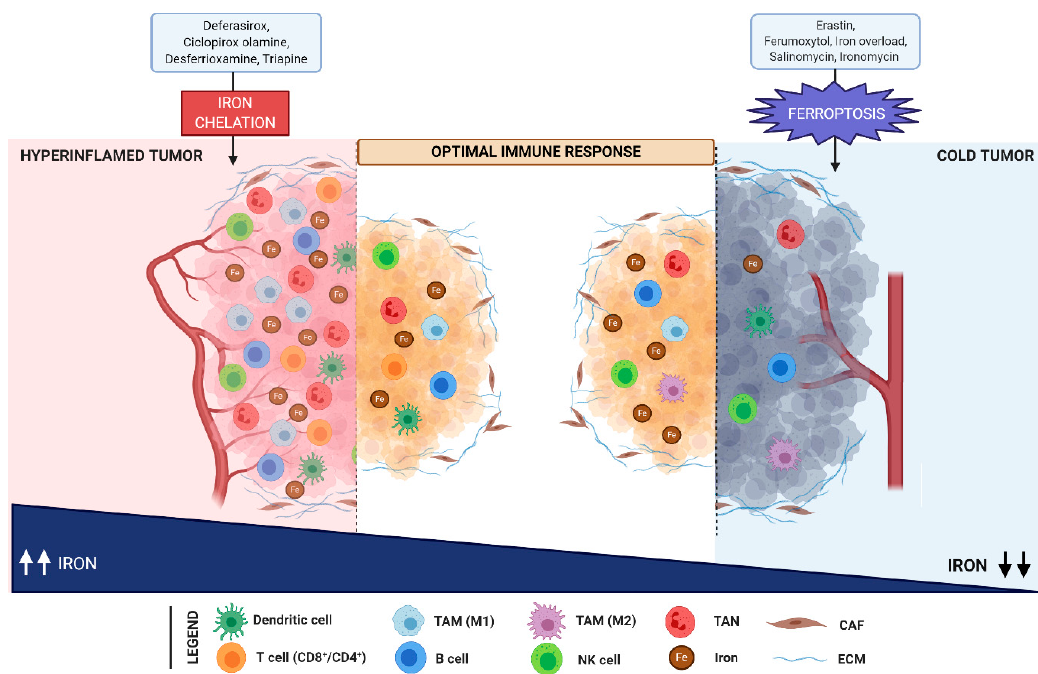
Figure 3. Iron levels modulate the immune response in the TME. Hyperinflamed tumors are enriched in immune cells infiltration (including dendritic cells, T- and B-cells, NK cells, TAN, and M1 macrophages) and are characterized by a high iron content. In contrast, cold tumors are poor in immune cells and are distinguished by iron deficiency. In hyperinflamed tumors, the reduction of iron overload upon treatment with iron chelators (such as deferasirox, ciclopirox olamine, desferrioxamine, and triapine), induces an efficient anti-tumor immune response. In parallel, ferroptosis mediated by erastin, ferumoxytol, salinomycin, and its synthetic derivative ironomycin foster anti-tumor immunity in cold tumors. Abbreviations used: TAM, tumor associated macrophages; TAN, tumor associated neutrophils; CAF, cancer associated fibroblasts; ECM, extracellular matrix; NK, natural killer.